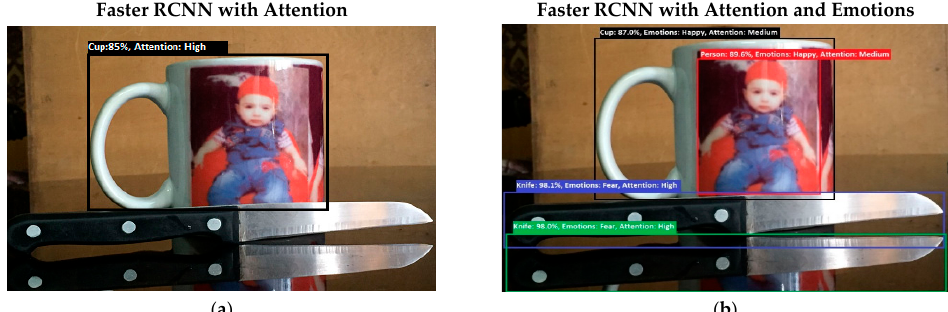
Figure 12. ( a ) In this experimental result, PSA system performs multiple attention processes. The system finds the desired object with a high attention level by ignoring other objects. In the given experiment, PSA was queried to “find Cup”. ( b ) Results from experiment 8 show PSA system performance in multiple attention processes. In the given experiment ( b ), PSA was queried to “find Cup”. The system finds the desired object, but the scene has other intensified emotional objects, so attention diverts toward those objects. Secondly, in the picture, as the knife reflection was clear in the mirror, the system wrongly counts the knife reflection as a knife.